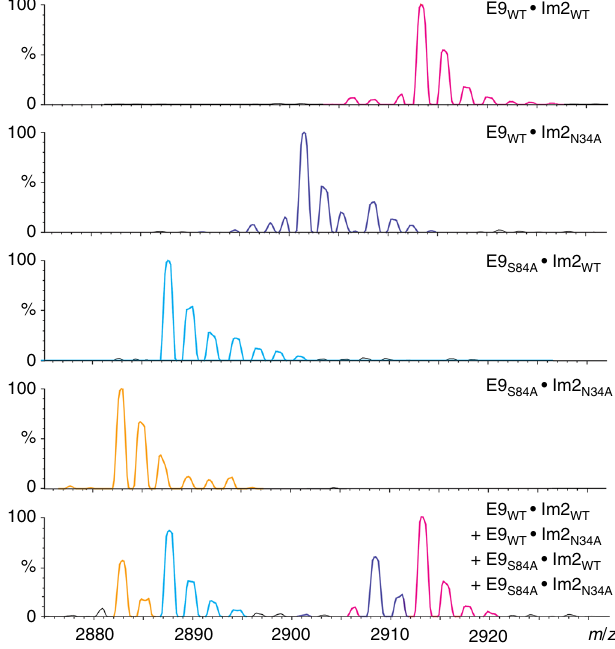
Fig. 3 Interaction of Ser84 in E9 with Asn34 in Im2 studied by native MS. Representative mass spectra of the +9 charge state are shown for the four pairs of complexes: E9 WT • Im2 WT ( magenta ), E9 WT • Im2 N34A ( purple ), E9 S84A • Im2 WT ( cyan ), and E9 S84A • Im2 N34A ( yellow ). All these complexes were formed using equal concentrations of the two binding partners. The spectrum in the bottom panel corresponds to all four proteins mixed together at relative respective concentrations of E9 WT , E9 S84A , Im2 WT , and Im2 N34A of 1:2:2:1, respectively. The highly resolved mass spectrum generated for the mixture of E9 WT , E9 S84A , Im2 WT , and Im2 N34A enabled us to distinguish between the four different complexes that are formed. Note that some peaks, which are present when only one complex is formed, are absent when all four complexes are formed together because each protein now forms two different complexes at a ratio that depends on the concentrations of all four proteins and their af fi